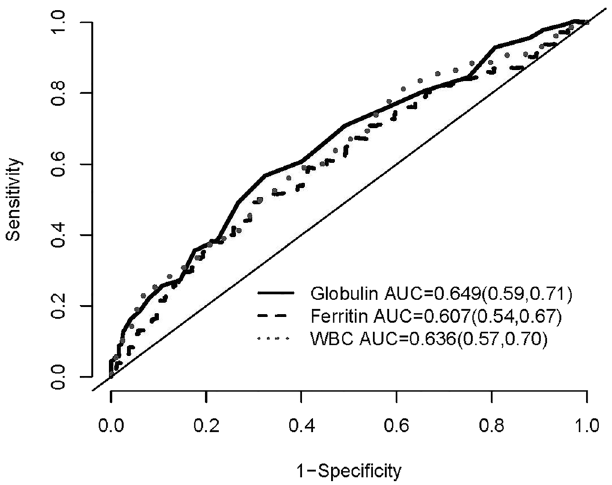
Figure 3. The area under the curve (AUC) by the receiver operating characteristics (ROC) curve analysis of the 3-year all-cause mortality for globulin, ferritin, and WBC counts. Numbers in parentheses indicate 95% confidence intervals.